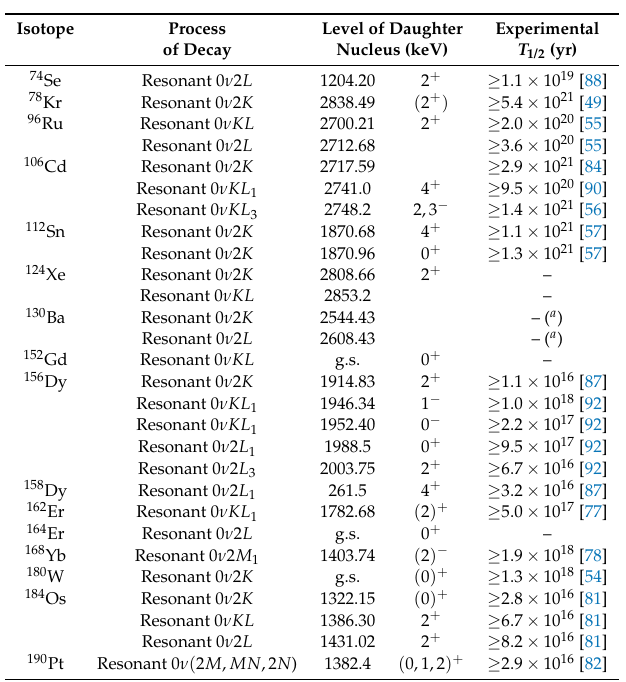
Table 8. Present best experimental results on T 1/2 of the resonant 0 ν 2 ε decay (limits are at 90% C.L.) for some of the isotopes most considered in the field. See